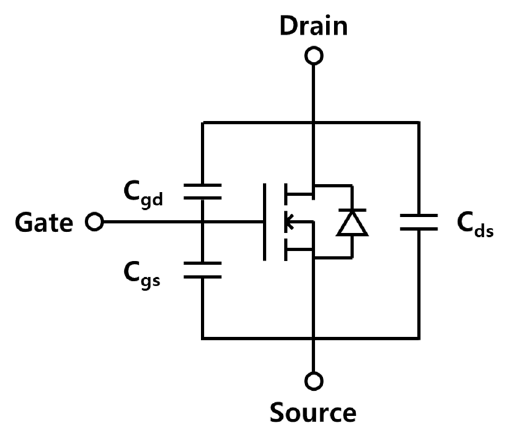
Figure 3. Parasitic components of